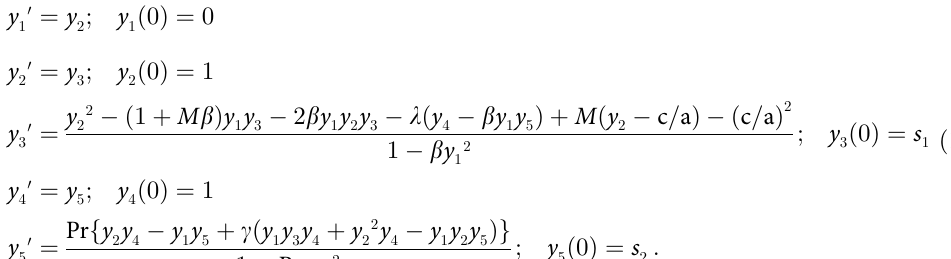
Table 1. Note that Eqs (11, 12 and13) reduce to the viscous fluid case when β = 0. Also, the analysis for usual Fourier law can be recovered by selecting γ = 0.